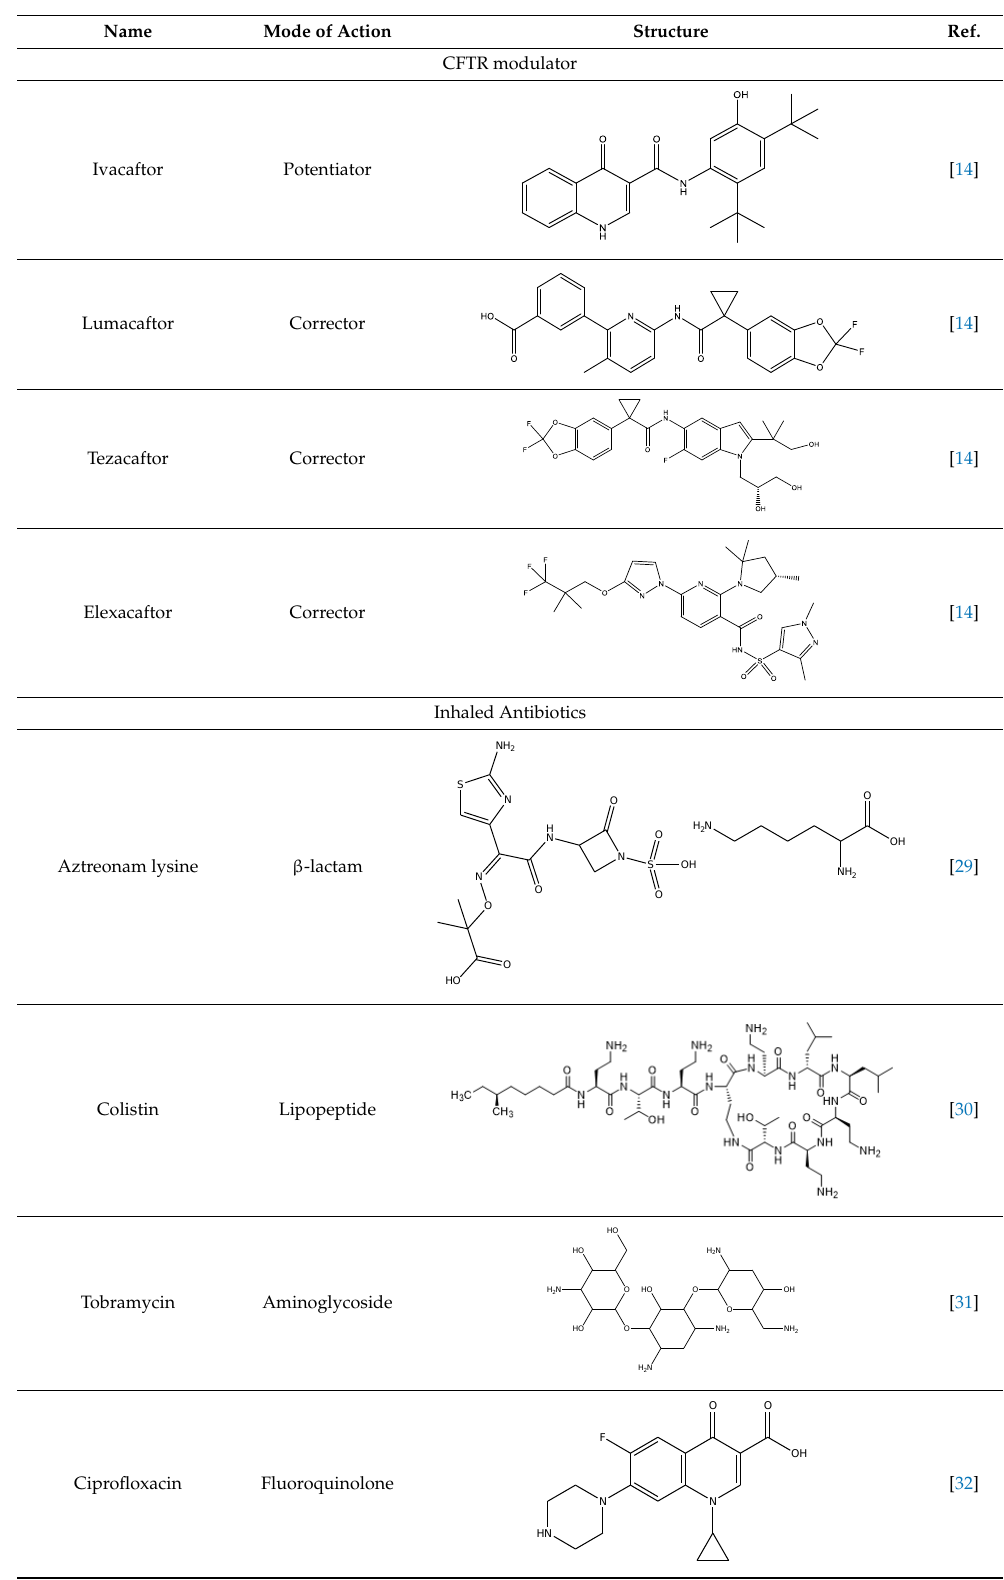
Table 2 . Structure of CF therapies Table 2 . Structure of CF therapies . Table 2 . Structure of CF therapies . Table 2 . Structure of CF therapies . Table 2 . Structure of CF therapies . Table 2 . Structure of CF therapies . Table 2. Structure of CF therapies.